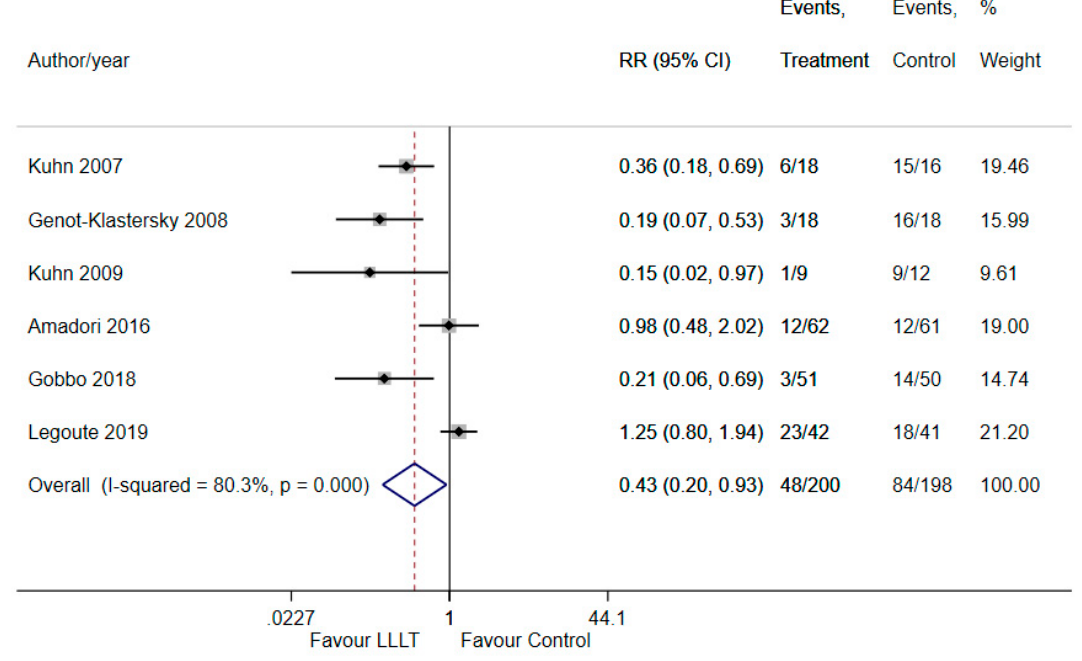
Figure 3. The forest plot illustrating the therapeutic benefit of PBM in reducing the severity of OM.